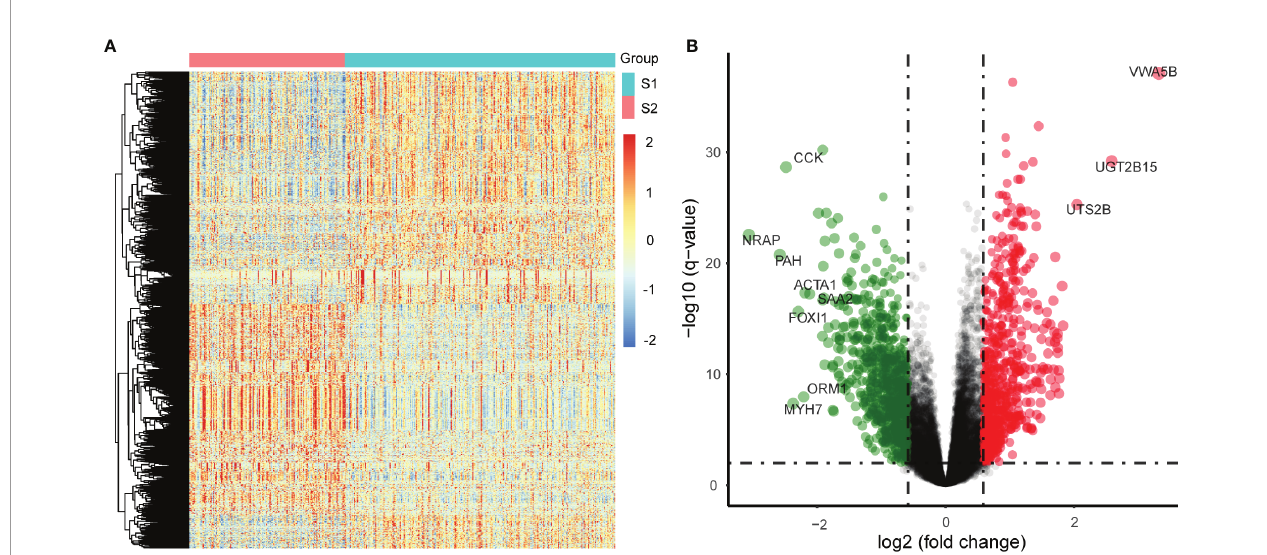
FIGURE 3 | Differentially expressed genes (DEGs) in the two subgroups from the TCGA PCa samples. (A) Differential expression: S2 vs S1, S1: a low relapse-risk subgroup of PCa, S2: a high relapse-risk subgroup of PCa. (B) Volcano plot of